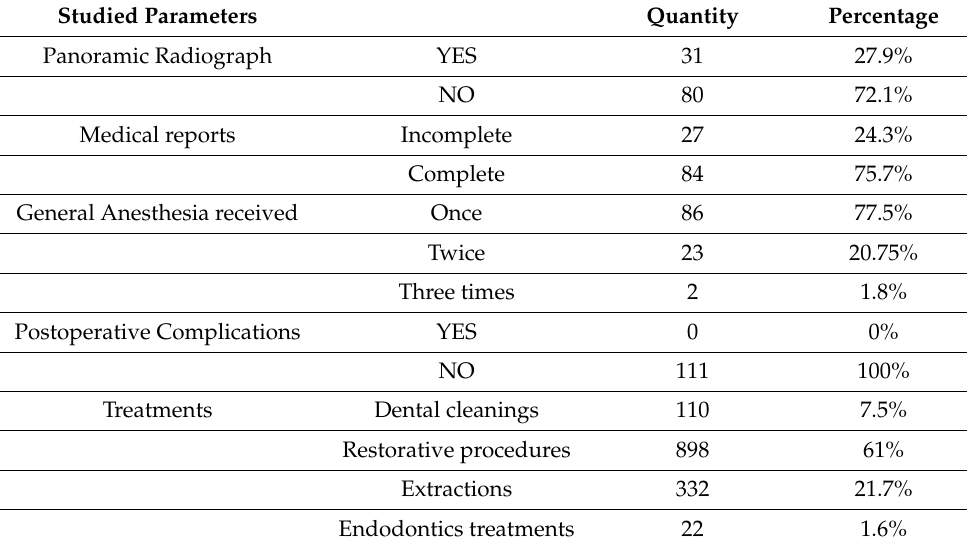
Table 2. Summary of the studied